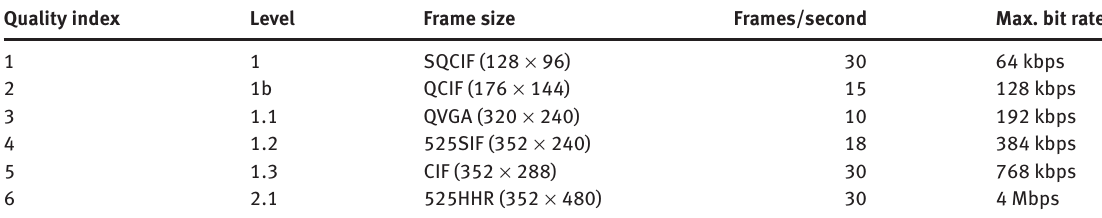
Table 4: Video Quality in H.264 Frame Format. Quality index